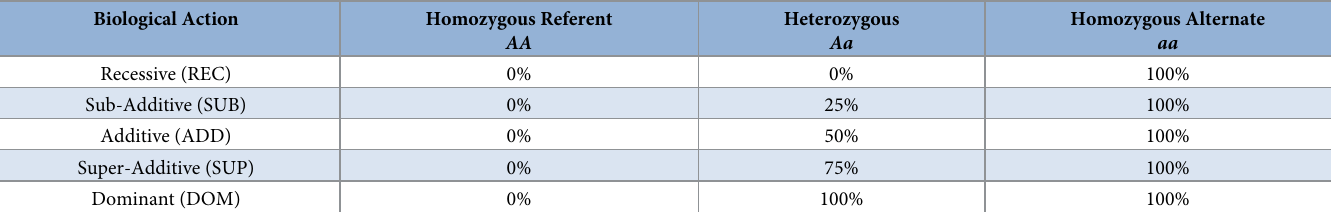
Table 1. Examples of possible proportional genotype risk underlying genetic